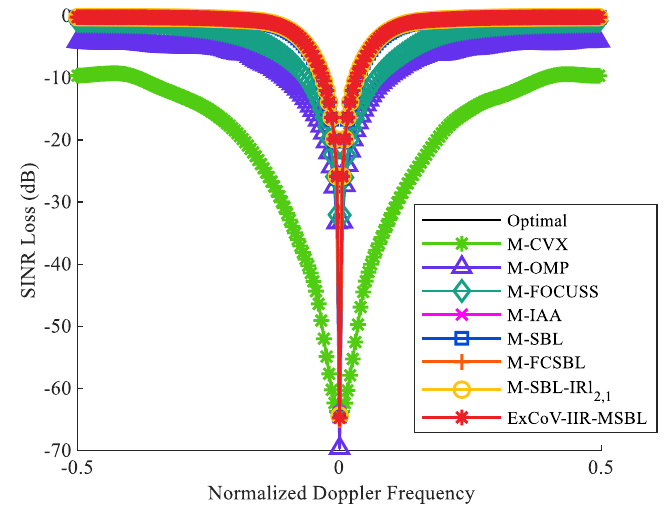
Figure 4 Figure 4. SINR loss comparison of different algorithms in the ideal